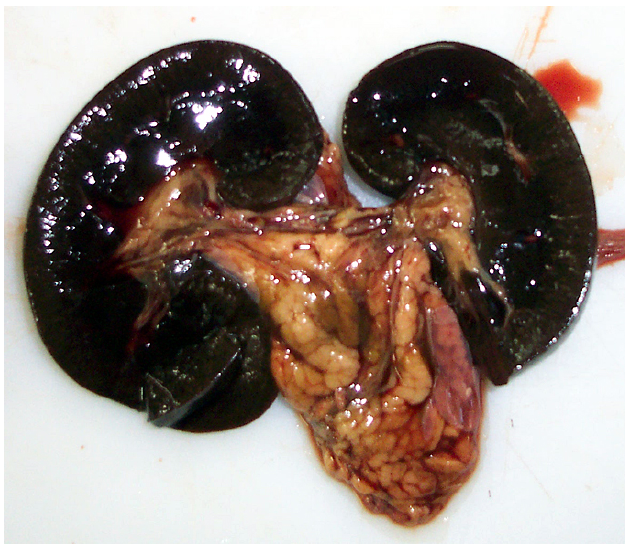
Figure 1. The dark kidneys are markers of